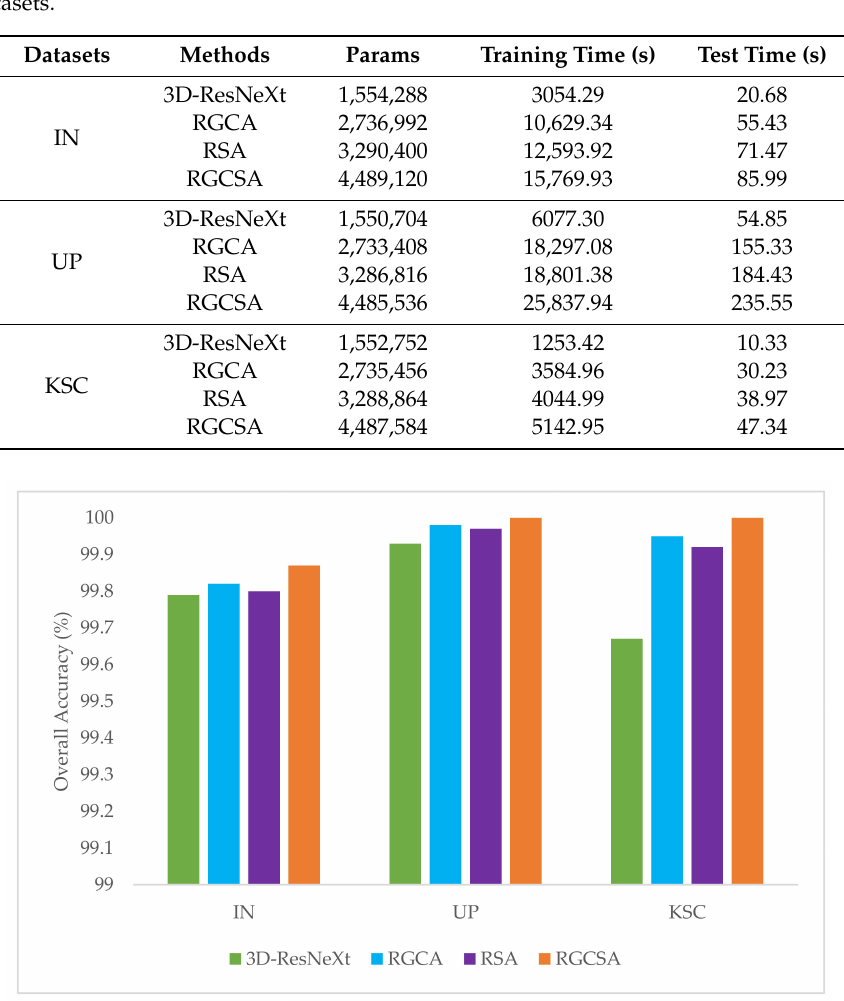
Figure 13. OAs of four di ff erent attention mechanisms on the three HSI